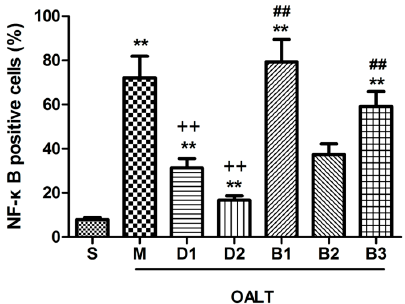
Figure 6. The ratio of phospho-NF- κ B subunit p65-positive cells in the liver tissue of the different groups. Cells were counted via LSCM (magnification, ×400). The data are expressed as the means ± SD ( n = 8). ** p < 0.01, vs. group S; ++ p < 0.01, vs. group M; ## p < 0.01, vs. group D2.